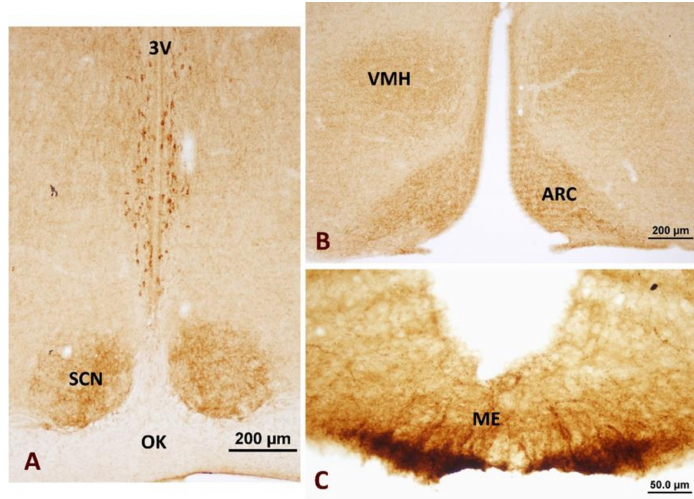
Figure 2. Distribution of neuronostatin-positive axon terminals in the hypothalamus. ( A ) Suprachiasmatic nucleus (SCN), ( B ) ventromedial hypothalamic nucleus (VMH) and arcuate nucleus (ARC), and ( C ) median eminence. 3V: third ventricle, OK: optic